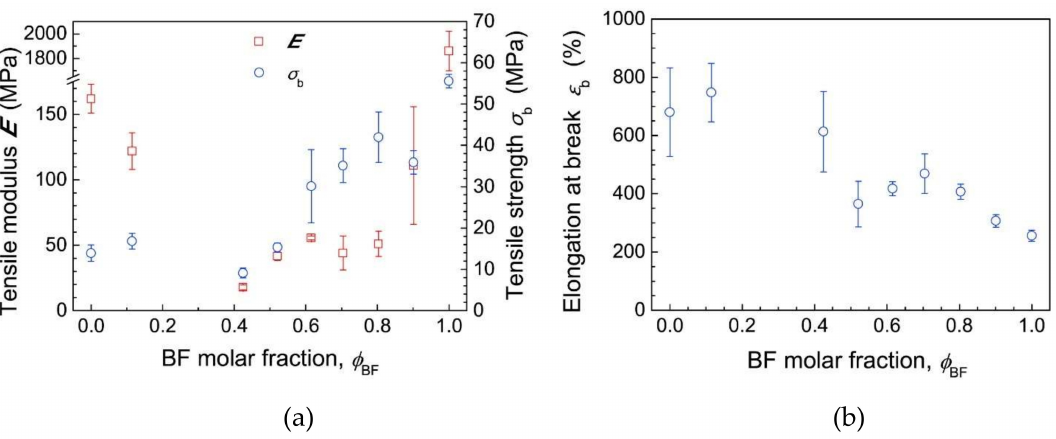
Figure 14. Composition dependences of the ( a ) Young’s modulus, tensile strength, and ( b ) elongation at break of PBF- co -PBAd copolyesters [73].